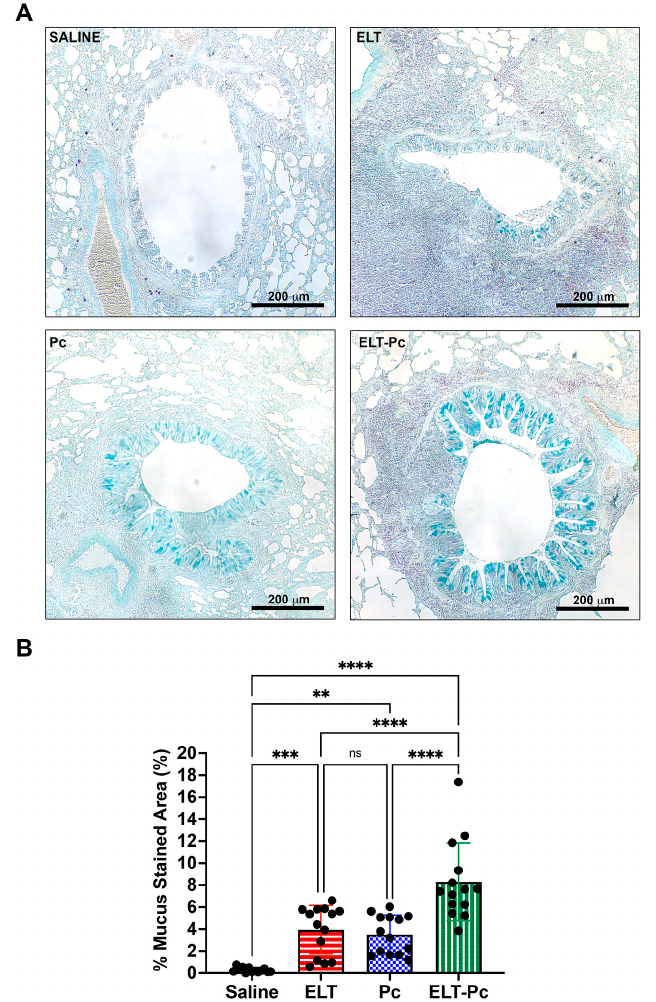
Figure 4. Evaluation of mucus secretion in the elastase-induced COPD animal model infected with Pneumocystis . ( A ) Representative images of lung sections from the four experimental animal groups stained with alcian-blue/periodic acid Schiff (AB/PAS). Microscopic magnification was 100×. ( B ) The stained area of the airway epithelium was quantified as described in the Materials and Methods section. Data are expressed as mean ± SD and analyzed by ANOVA. ns = non significant; ** = p < 0.01; *** = p < 0.001; **** = p < 0.0001.